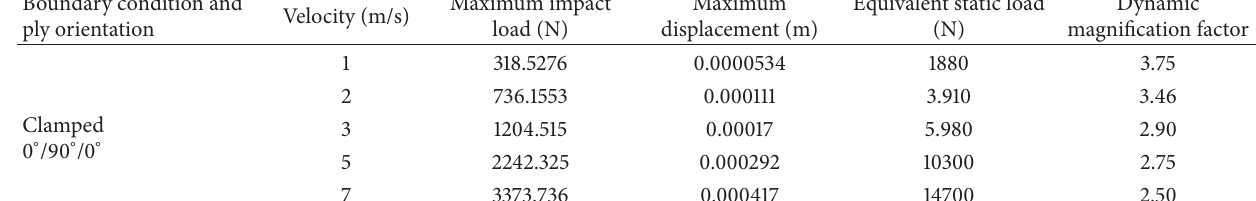
Table 3: Maximum contact force, maximum dynamic displacement, equivalent static load, dynamic magnification factor for different velocities.